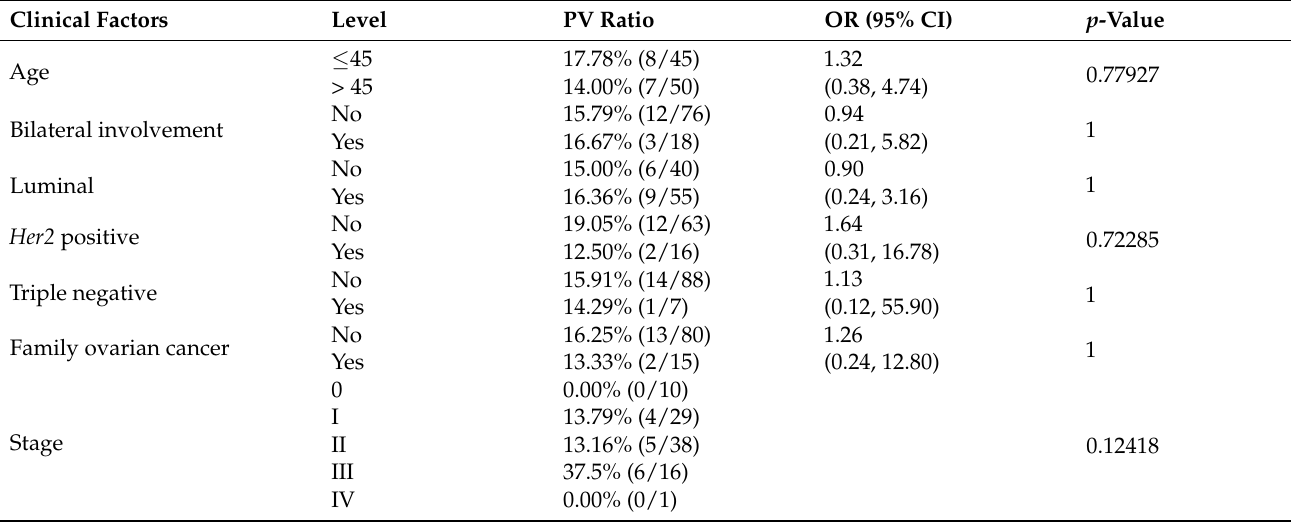
Table 3. Comparison of the odds ratio (OR) of pathogenic variants (PVs) in different groups for each clinical factor using Fisher exact tests.